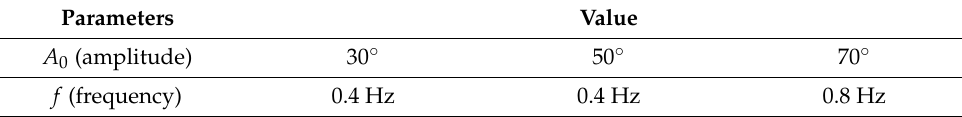
Table 2. The movement parameters of